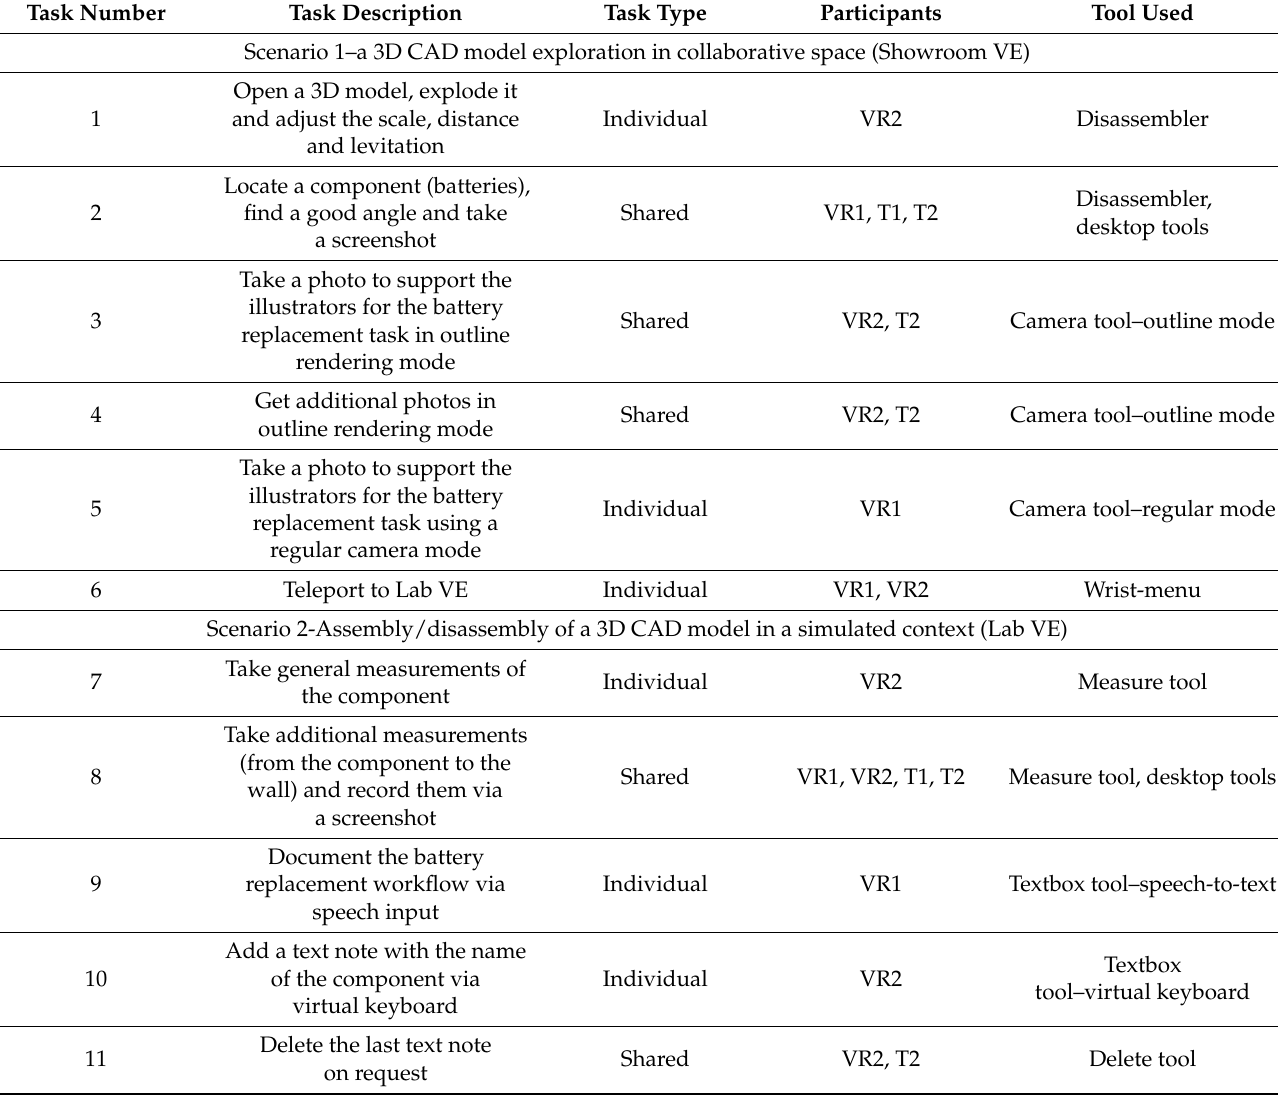
Table 1. Tasks for the user